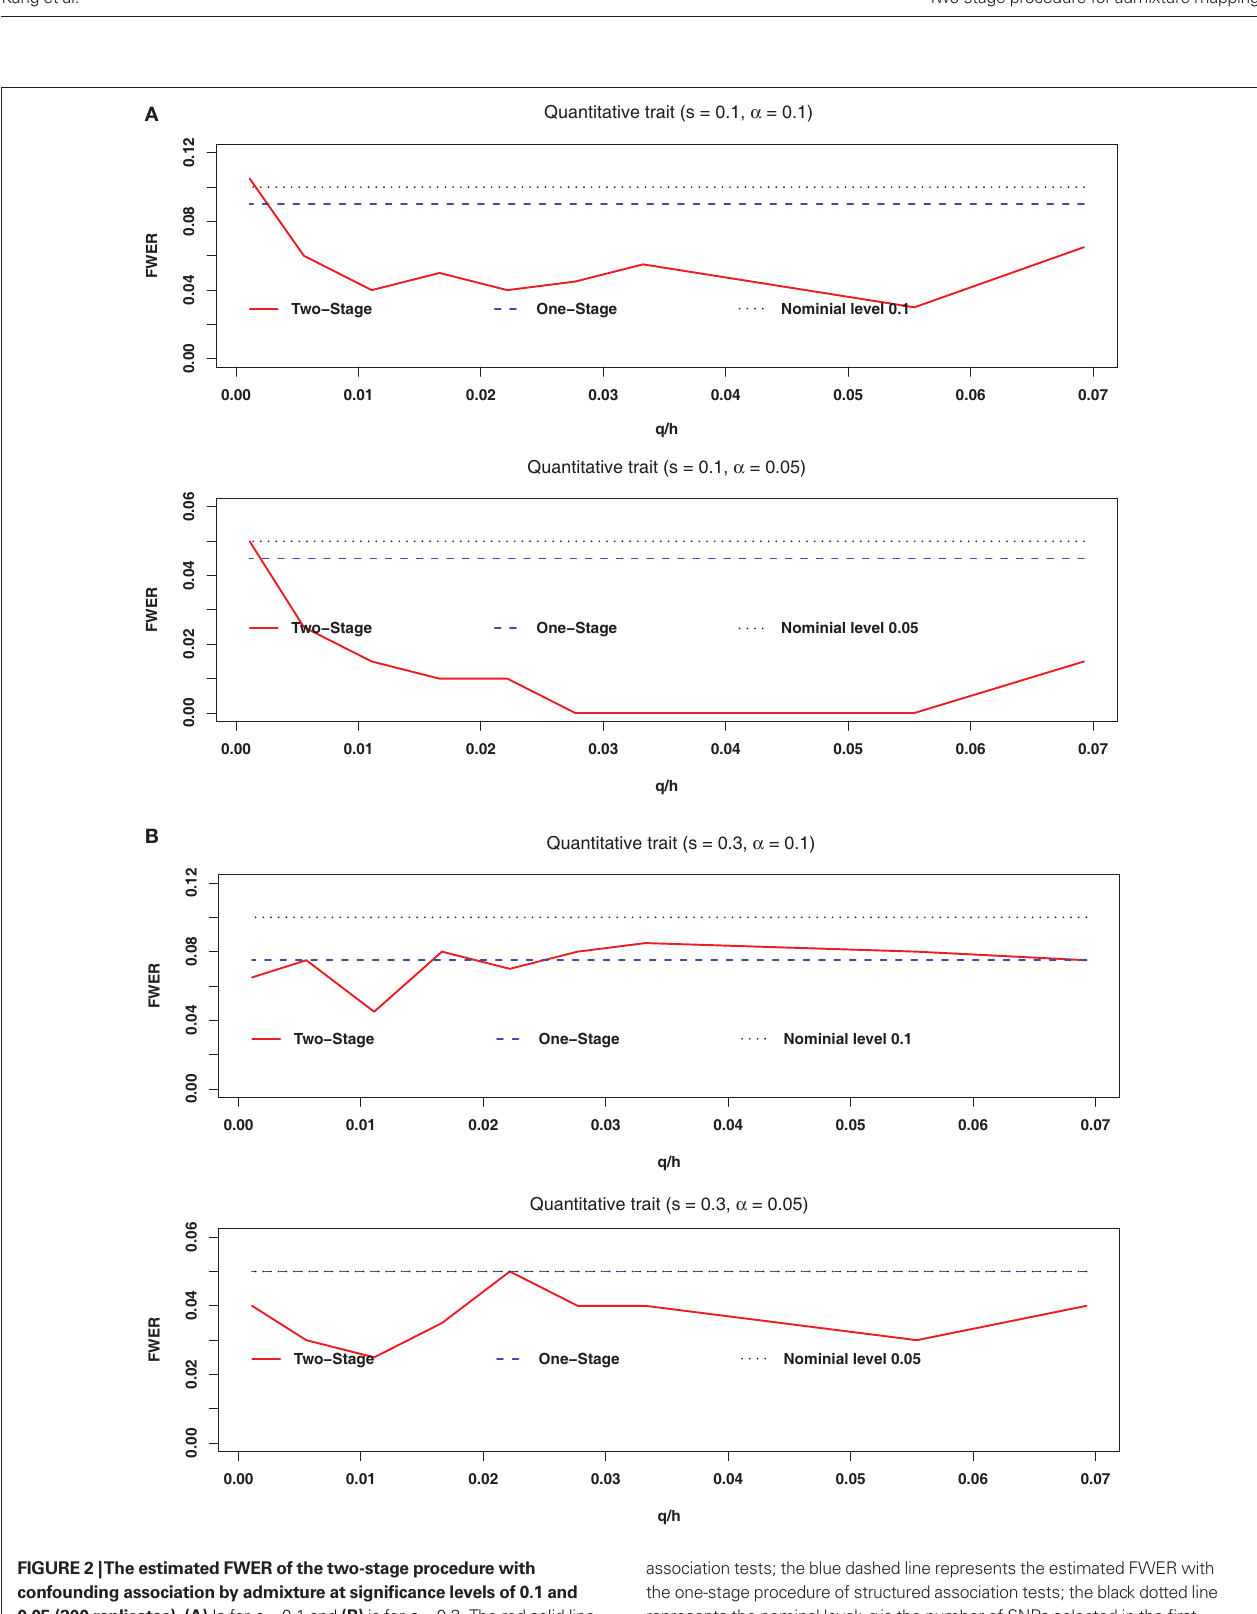
FiGure 2 | The estimated FWer of the two-stage procedure with confounding association by admixture at significance levels of 0.1 and 0.05 (200 replicates). (A) Is for s = 0.1 and (B) is for s = 0.3. The red solid line represents the estimated FWER with the two-stage procedure of structured